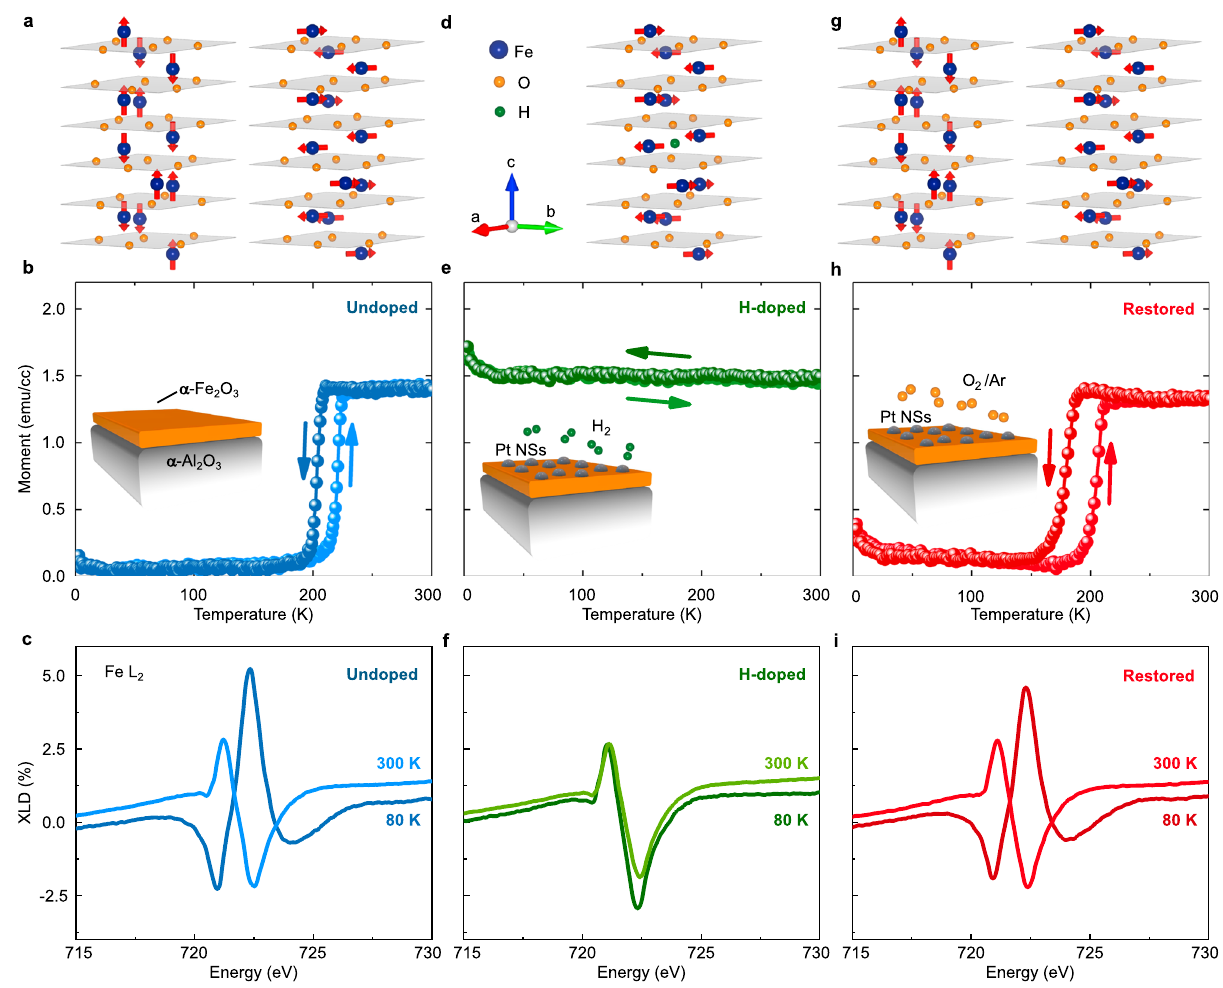
Fig. 1 Reversible control of the antiferromagnetic Néel vector orientation and the Morin transition by H-doping. a Schematic of α -Fe 2 O 3 crystal unit cell and the spin alignment at T < T M (left) and T > T M (right). b M ( T ) curve of undoped α -Fe 2 O 3 fi lms during up/down temperature sweeps in a measuring 0 0 fi eld of 500 Oe (following fi eld cooling at 500 Oe), exhibited a transition with the appearance/disappearance of the in-plane canted moment. c Fe L 2 edge XLD spectra measured below (80 K) and above (300 K) T M , showed opposite signatures, validating the anisotropy switch in ( a ). d – f Unit cell of H-doped 0 α -Fe M ( T ) curve ( e ), and XLD showing the same 2 O 3 with in-plane L orientation throughout the temperature range ( d ), deduced from the transition-less asymmetry at 80 K and 300 K ( f ). g – i Unit cell of H-doped α -Fe 2 O 3 sample after restoration step in 100% O 2 atmosphere, exhibited the out-of-plane to in- plane L transition ( g ), inferred from the return of the Morin transition in M ( T ) ( h ), and XLD showing asymmetry reversal ( i ). The restored state can also be obtained by annealing the H-doped fi lms in 100% Ar atmosphere (see Supplementary-S5). Insets in ( b , e , h ) correspond to the sample structure of b undoped, e H-doped, h restored α -Fe 2 O 3 fi lms in corresponding environments. The discontinuous Pt nano-structures (NSs) are also